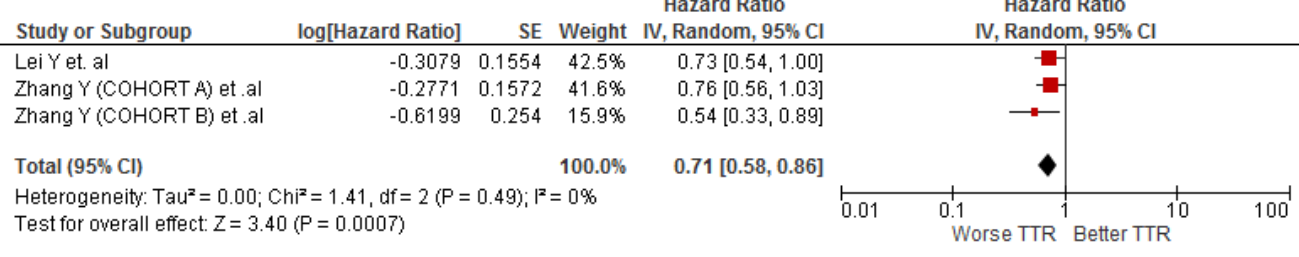
Figure 5. Association of LMR and TTR in patients with cholangiocarcinoma.